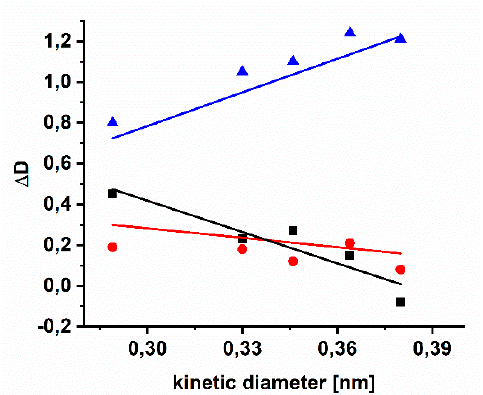
Figure 7. Change of diffusivity coefficient of different gases depending on their kinetic diameter ( Δ D = (D 250 °C − D 30 °C )/D 30 °C ) (AZ-PIM-100 (black squares), AZ-PIM-R50 (red circles), AZ-PIM-A50 (blue triangles)).